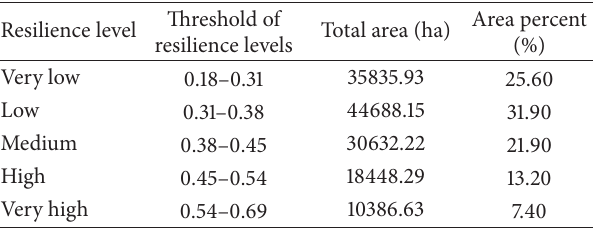
Table 2: Threshold of forest resilience level and total area at each resilience